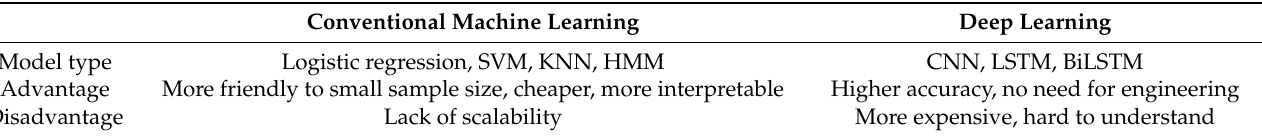
Table 2. The comparison of fall risk modeling